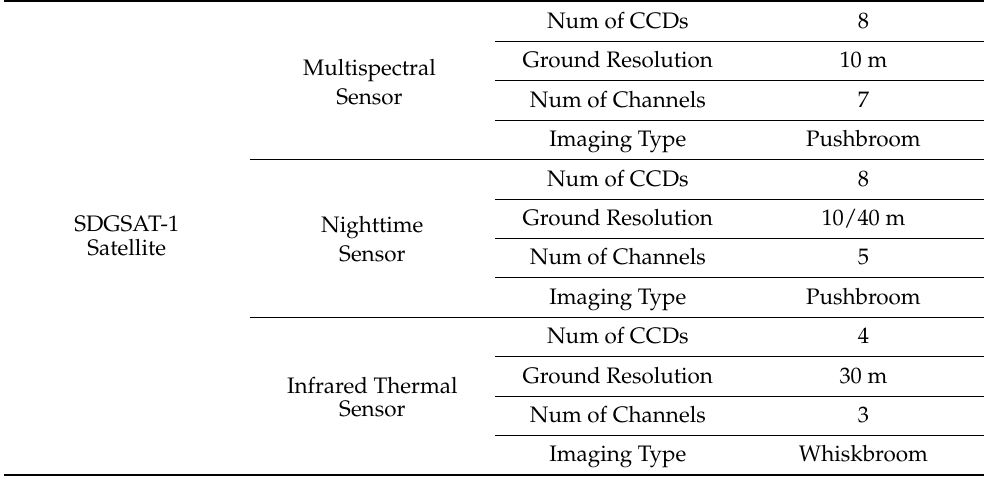
Table 1. Designed characteristics of the SDGSAT-1